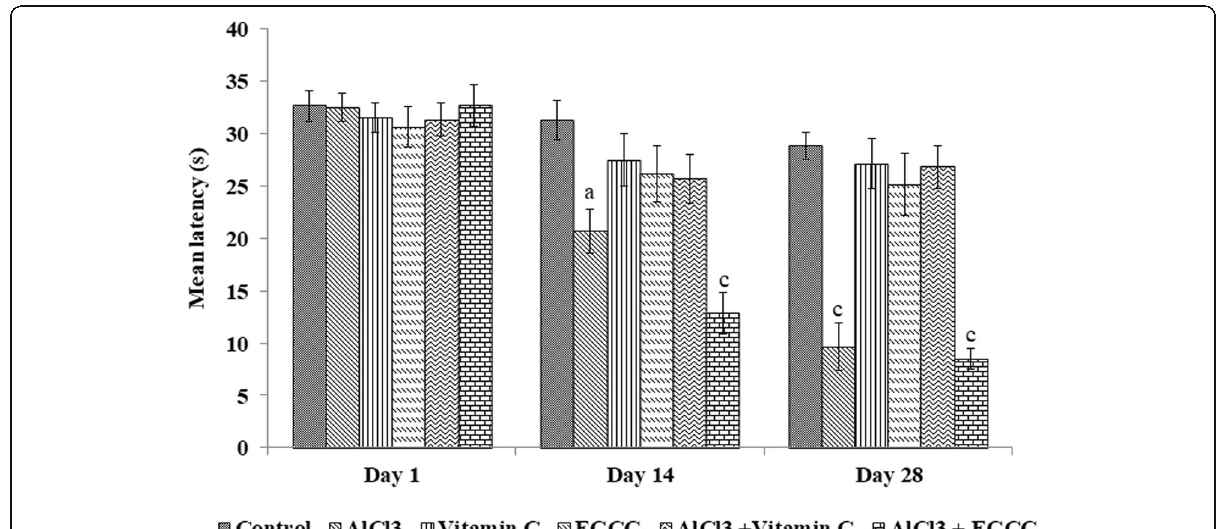
Fig. 3 Effect of EGCG on wire grip strength of the rats. Values are expressed as mean ± SEM ( n = 6). a P < 0.05 and c P < 0.001 compared with control (one-way ANOVA followed by Tukey ’ s post-hoc